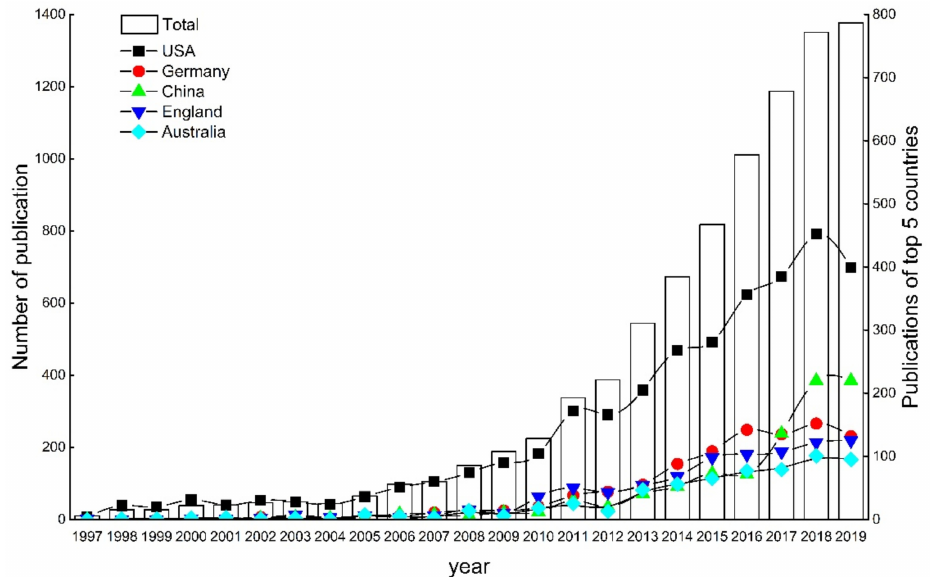
Figure 1. Number of FES publications by year from 1997 to